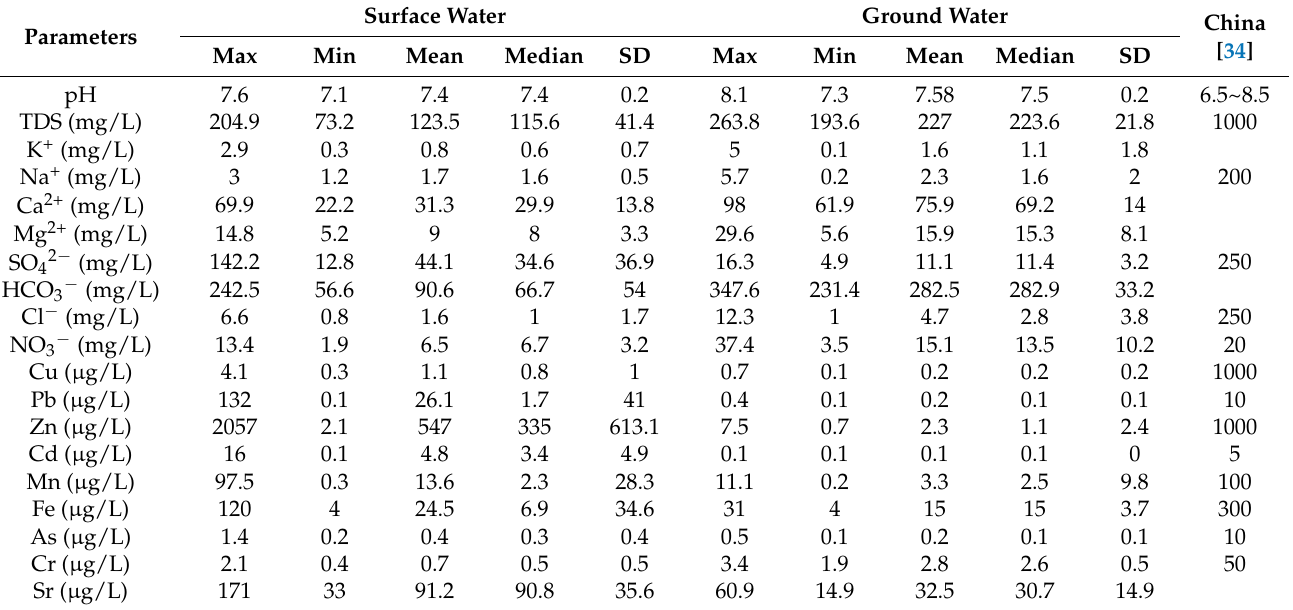
Table 1. Statistics of physicochemical and chemical parameters and the parameters for water quality index (WQI) calculation in river water and groundwater in the Sidi River’s karst